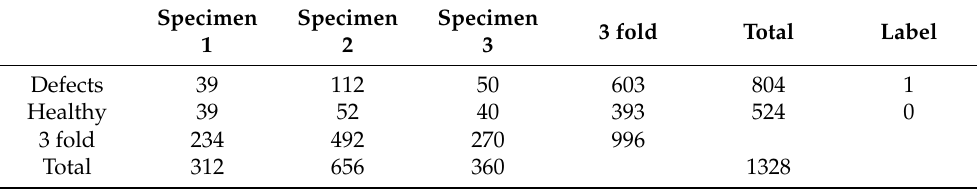
Figure 7. The ultrasonic nondestructive testing of insulator defects. Table 3. The number of insulator datasets before and after data augmentation. Table 3. The number of insulator datasets before and after data